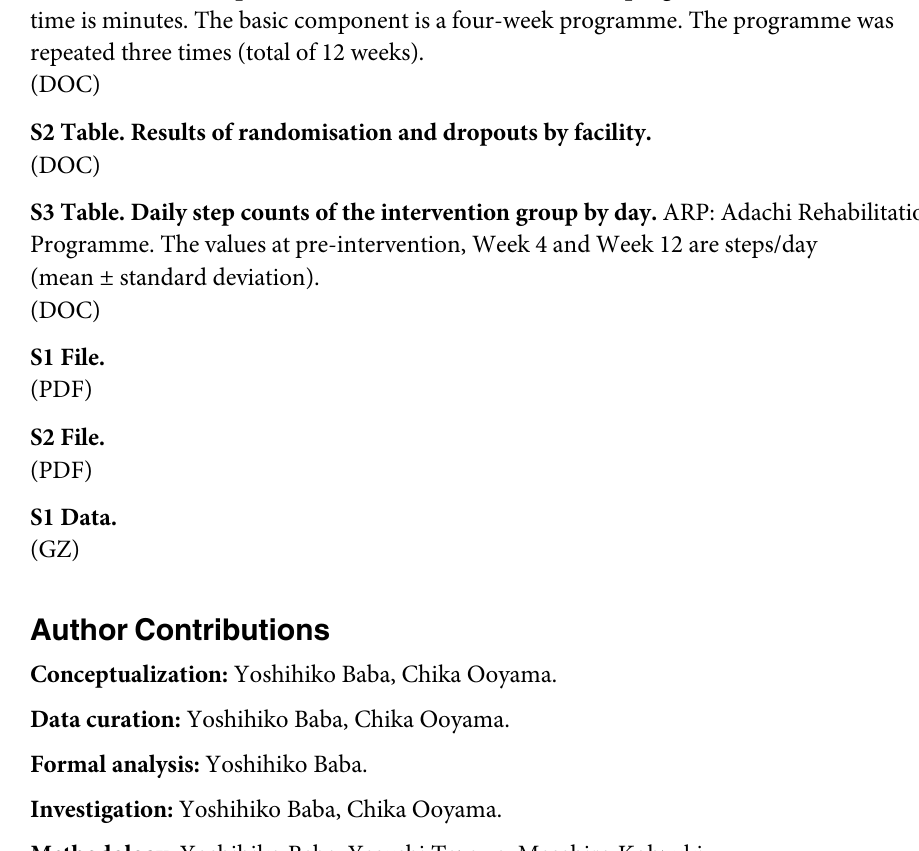
S1 Table. Basic components of the Adachi Rehabilitation programme. Note: The unit of time is minutes. The basic component is a four-week programme. The programme was repeated three times (total of 12 weeks). S2 Table. Results of randomisation and dropouts by facility. S3 Table. Daily step counts of the intervention group by day. ARP: Adachi Rehabilitation Programme. The values at pre-intervention, Week 4 and Week 12 are steps/day (mean ± standard